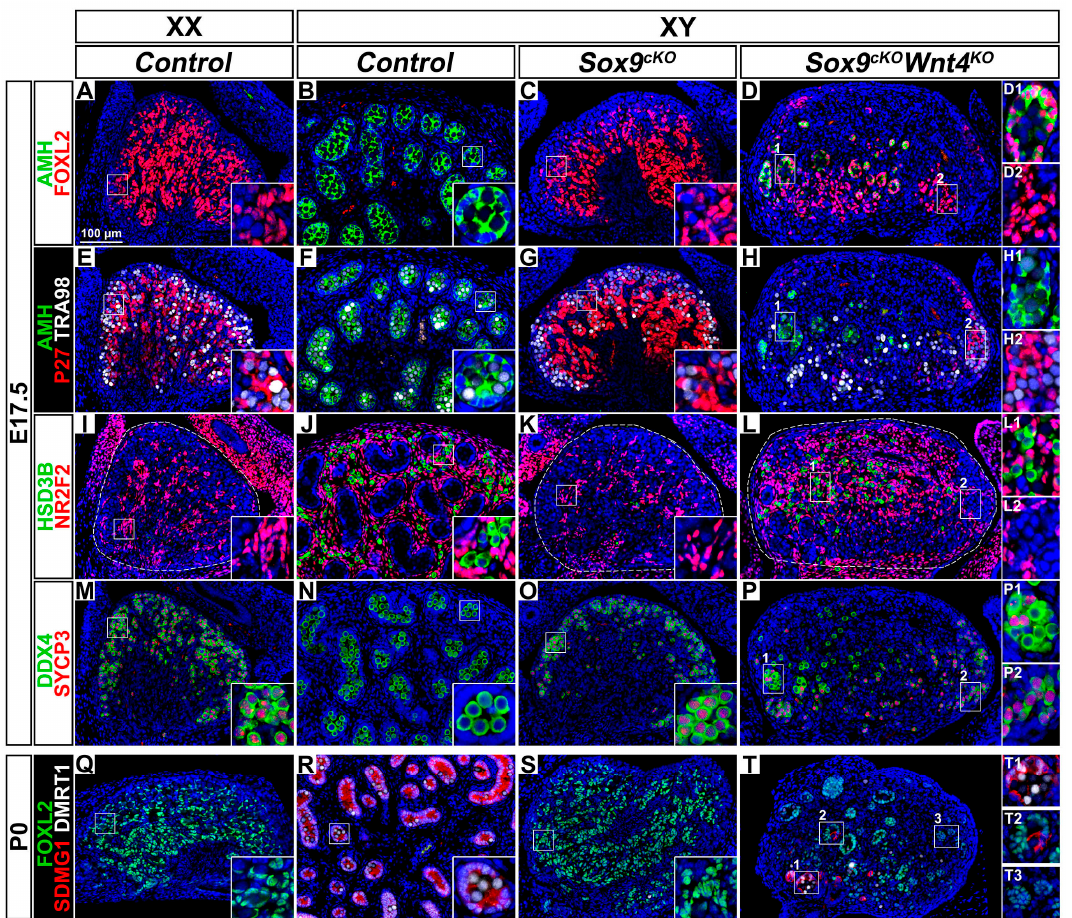
Figure 6. Ovotestis development in XY Sox9; Wnt4 double mutant gonads at E17.5 and P0. ( A – D ) Immunodetection of the granulosa differentiation and Sertoli cell marker AMH (green) and the pre-granulosa cell marker FOXL2 (red) in E17.5 gonads of XX Control ( A ), XY Control ( B ), XY Sox9 cKO ( C ), and XY Sox9 cKO Wnt4 KO ( D ) genotypes. ( E – H ) Immunodetection of AMH (green), the quiescent cell marker P27 (red) and the germ cell marker TRA98 (white) in E17.5 gonads of XX Control ( E ), XY Control ( F ), XY Sox9 cKO ( G ), and XY Sox9 cKO Wnt4 KO ( H ) genotypes. ( I – L ) Immunodetection of the steroidogenic cell marker HSD3ß (green) and the interstitial and stromal cell marker NR2F2 (red) in E17.5 gonads of XX Control ( I ), XY Control ( J ), XY Sox9 cKO ( K ), and XY Sox9 cKO Wnt4 KO ( L ) genotypes. ( M – P ) Immunodetection of the germ cell marker DDX4 (green) and the meiosis marker SYCP3 (red) in E17.5 gonads of XX Control ( M ), XY Control ( N ), XY Sox9 cKO ( O ), and XY Sox9 cKO Wnt4 KO ( P ) genotypes. ( Q – T ) Immunodetection of the pre-granulosa cell marker FOXL2 (green), the Sertoli cell marker SDMG1 (red) and the Sertoli cell and male germ cell marker DMRT1 (white) in newborn gonads of XX Control ( Q ), XY Control ( R ), XY Sox9 cKO ( S ), and XY Sox9 cKO Wnt4 KO ( T ) genotypes. Nuclei labeled with DAPI are shown in blue. Magnification is the same in all panels. Scale bar = 100 µm. Regions marked by numbers in panels D , H , L , P , and T are shown in the corresponding insets. Gonads are outlined with broken white lines in I , K , and L .